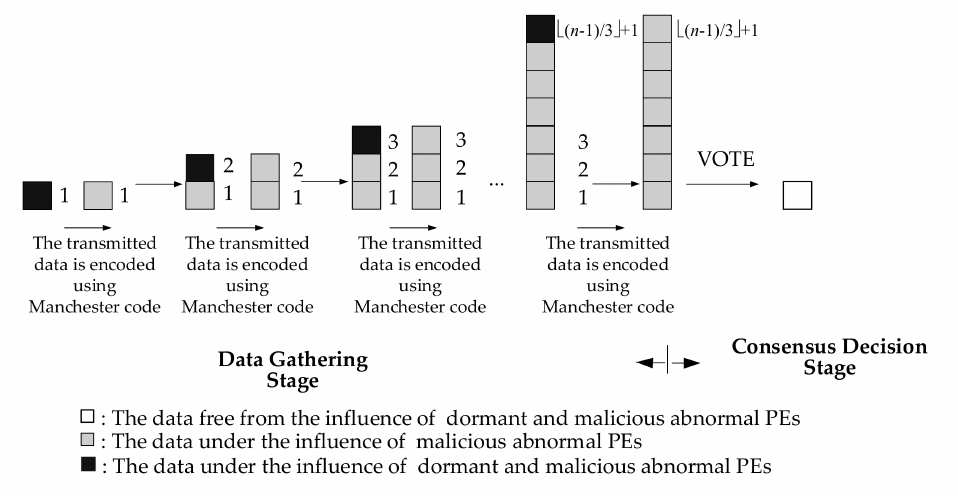
Figure 3. The progression of the influence of dormant and malicious abnormal processing elements (PEs)